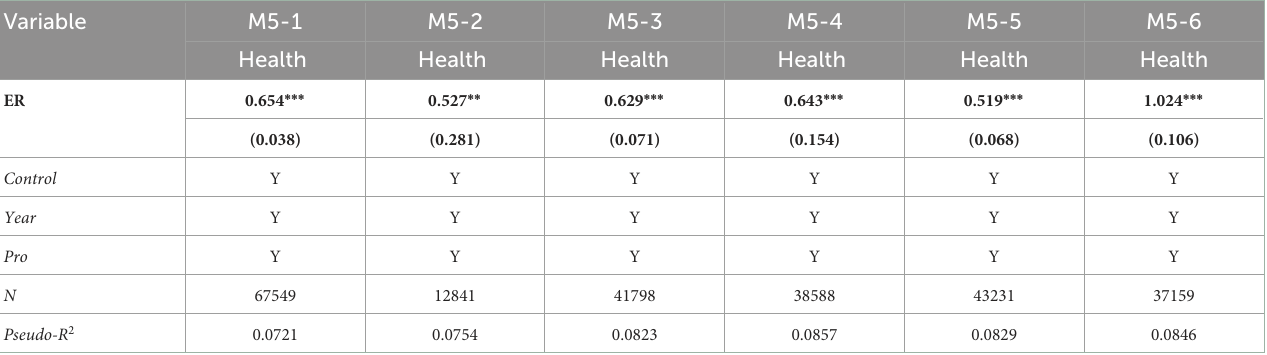
TABLE 5 Heterogeneity